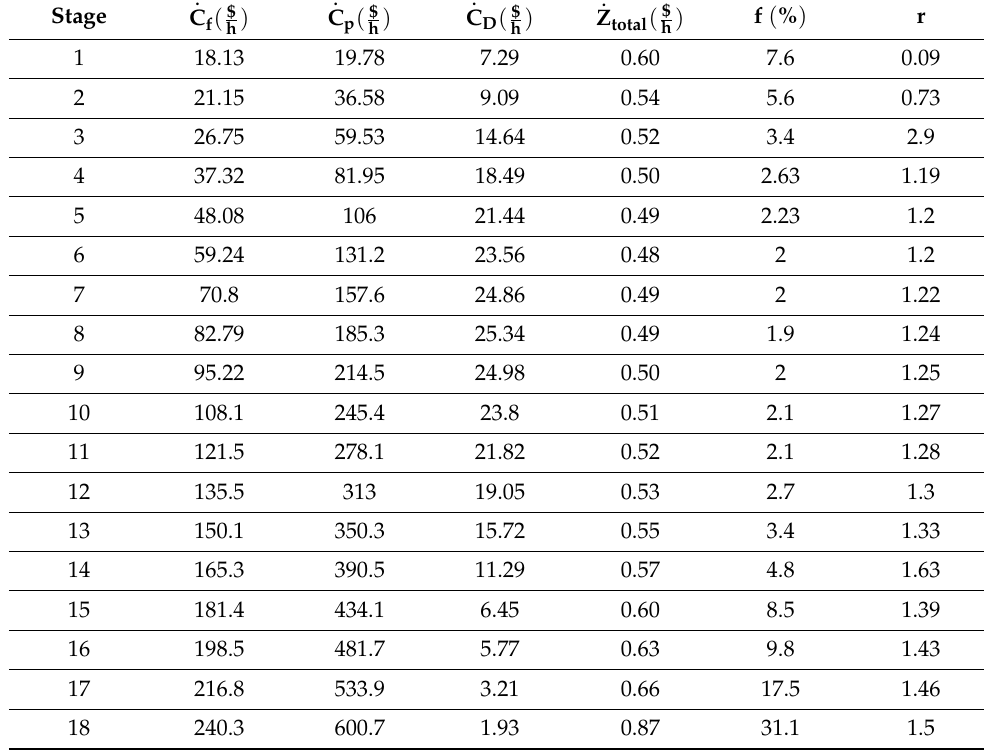
Table 7. Exergoeconomic and cost parameters for each stage of the MSF-BR desalination system. Stage